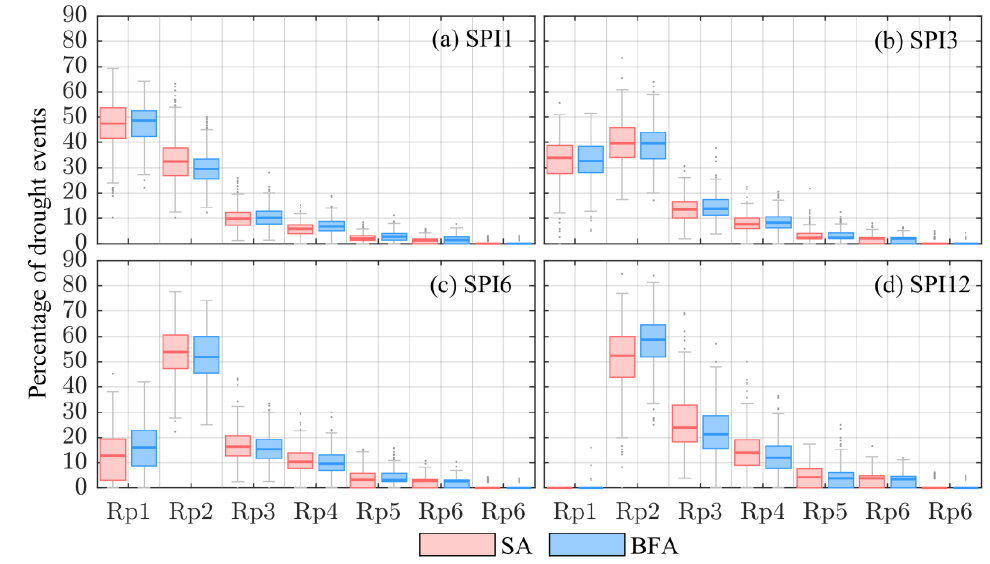
Figure 6. Boxplots representing the percentage of drought events detected by the two approaches lying in each return period class (Rp) for each SPI time scale.